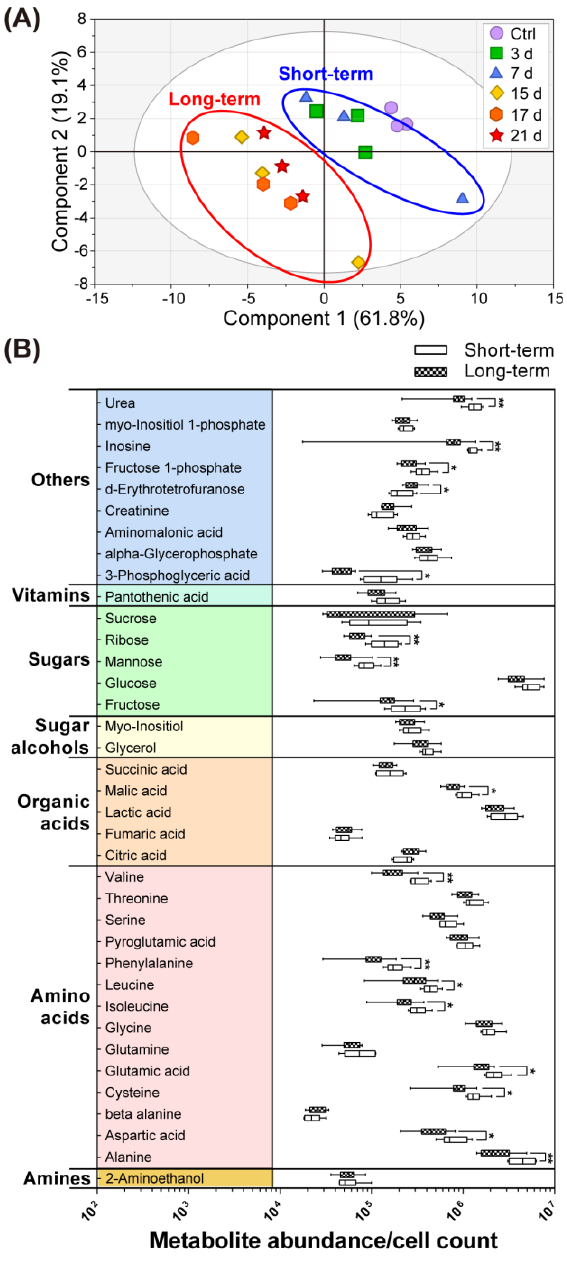
Figure 2. Observation of metabolic changes according to short-/long-term exposure. ( A ) PLS-DA score plots of the metabolites exposed to HBB for different number of day. ( B ) Box plots of short-term and long-term groups with metabolite abundance normalized by cell count. The unit of x -axis represents the normalized abundance data on a log scale. Significant differences are indicated by t-test results (* p < 0.05, ** p < 0.01). Table 1. Statistical results of comparison of short-term and long-term HBB exposure group.